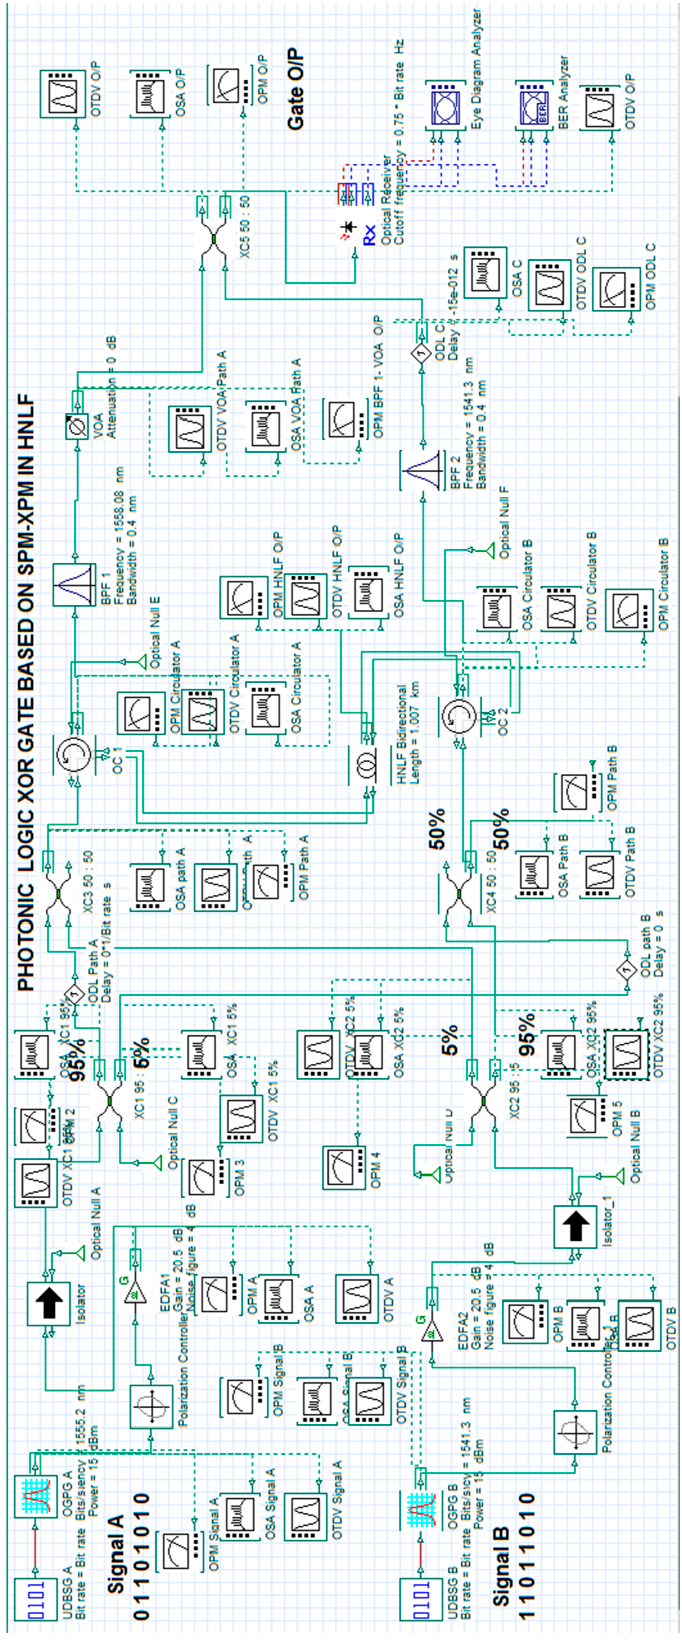
Figure 2. Design setup of the XOR logic gate.